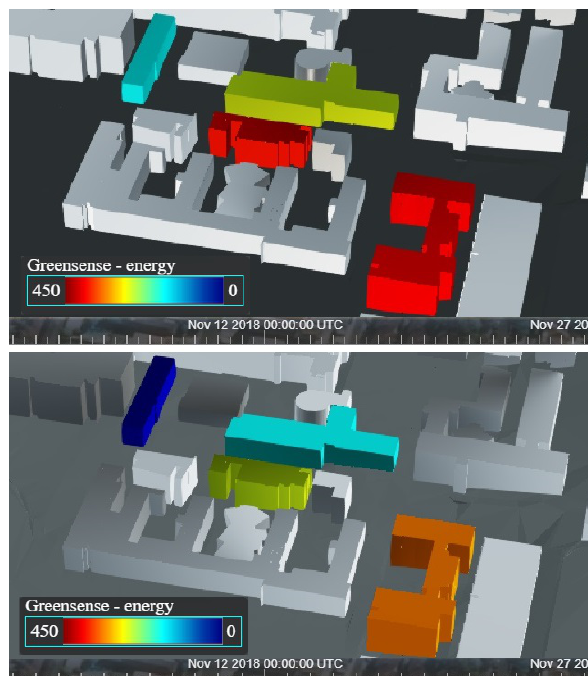
Figure 12. Energy consumption for 4 buildings at two different time slots.